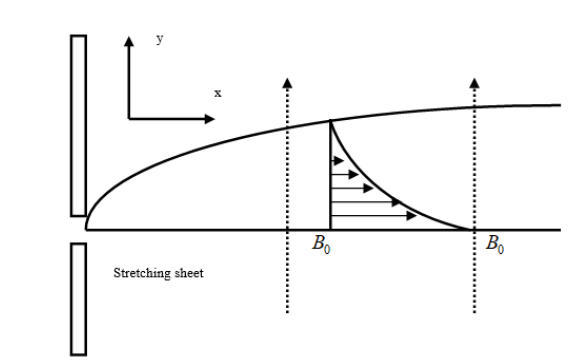
Figure 1: Physical model and coordinate